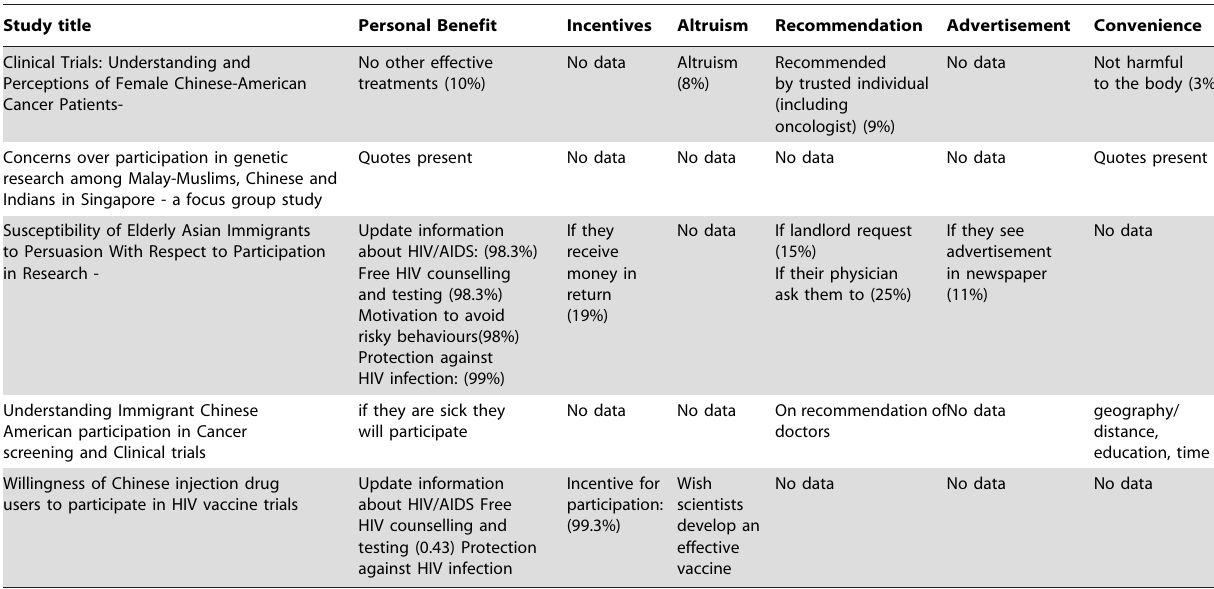
Table 1. Factors favoring participation in clinical